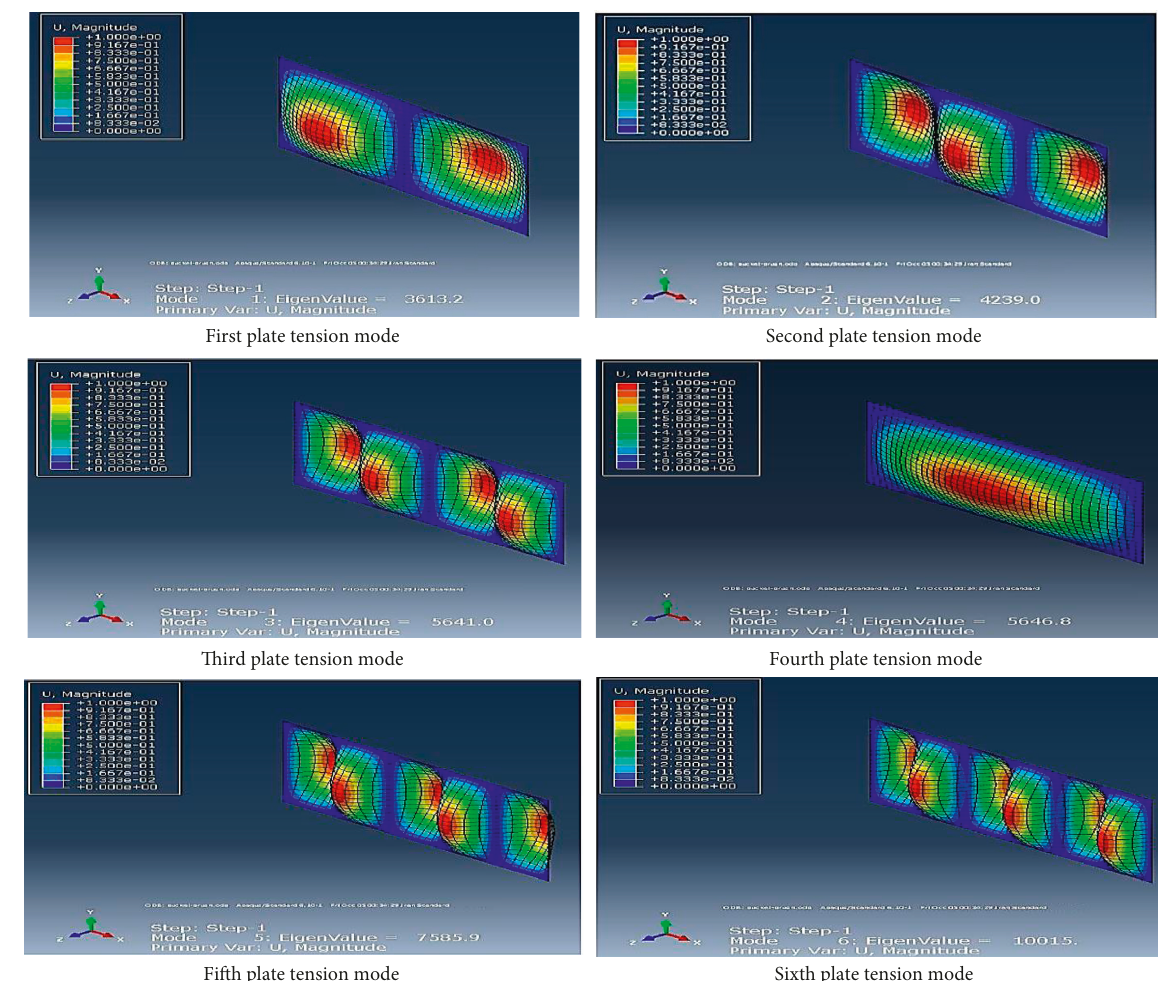
Figure 3: Tension modes of homogeneous and isotropic plate.